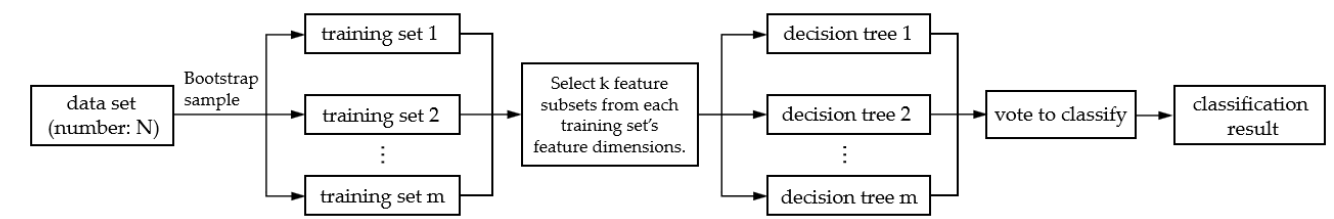
Figure 1. Construction of random forest.